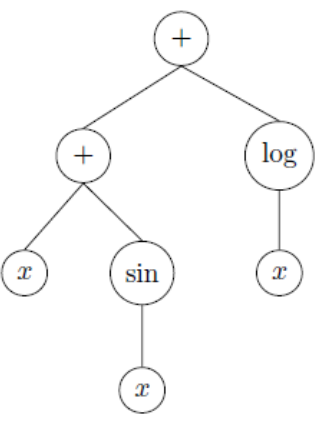
Figure 1. Example of a coded